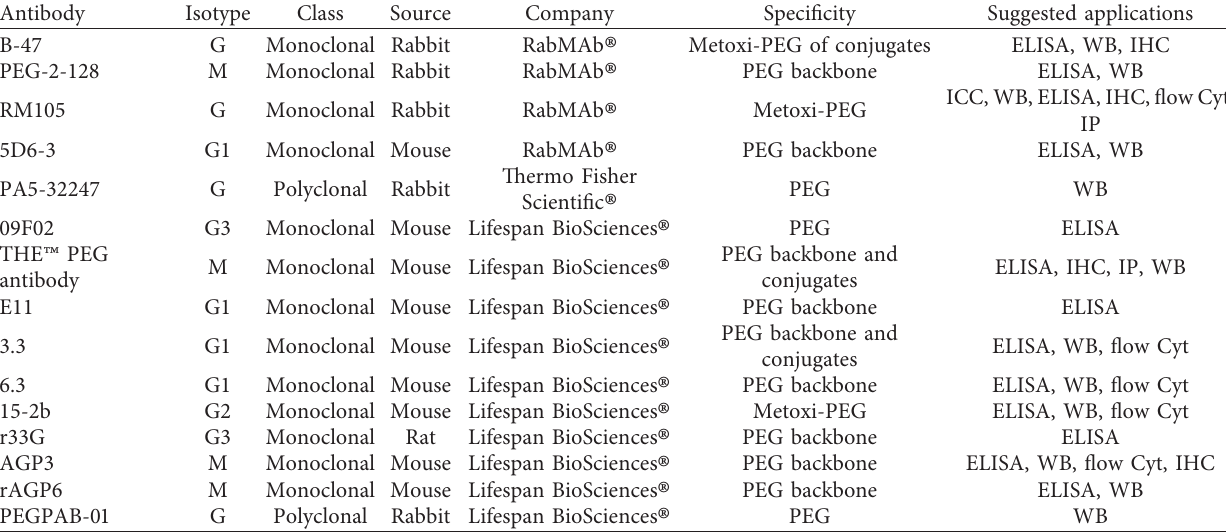
Table 1: Commercial anti-PEG antibodies and recommended applications.